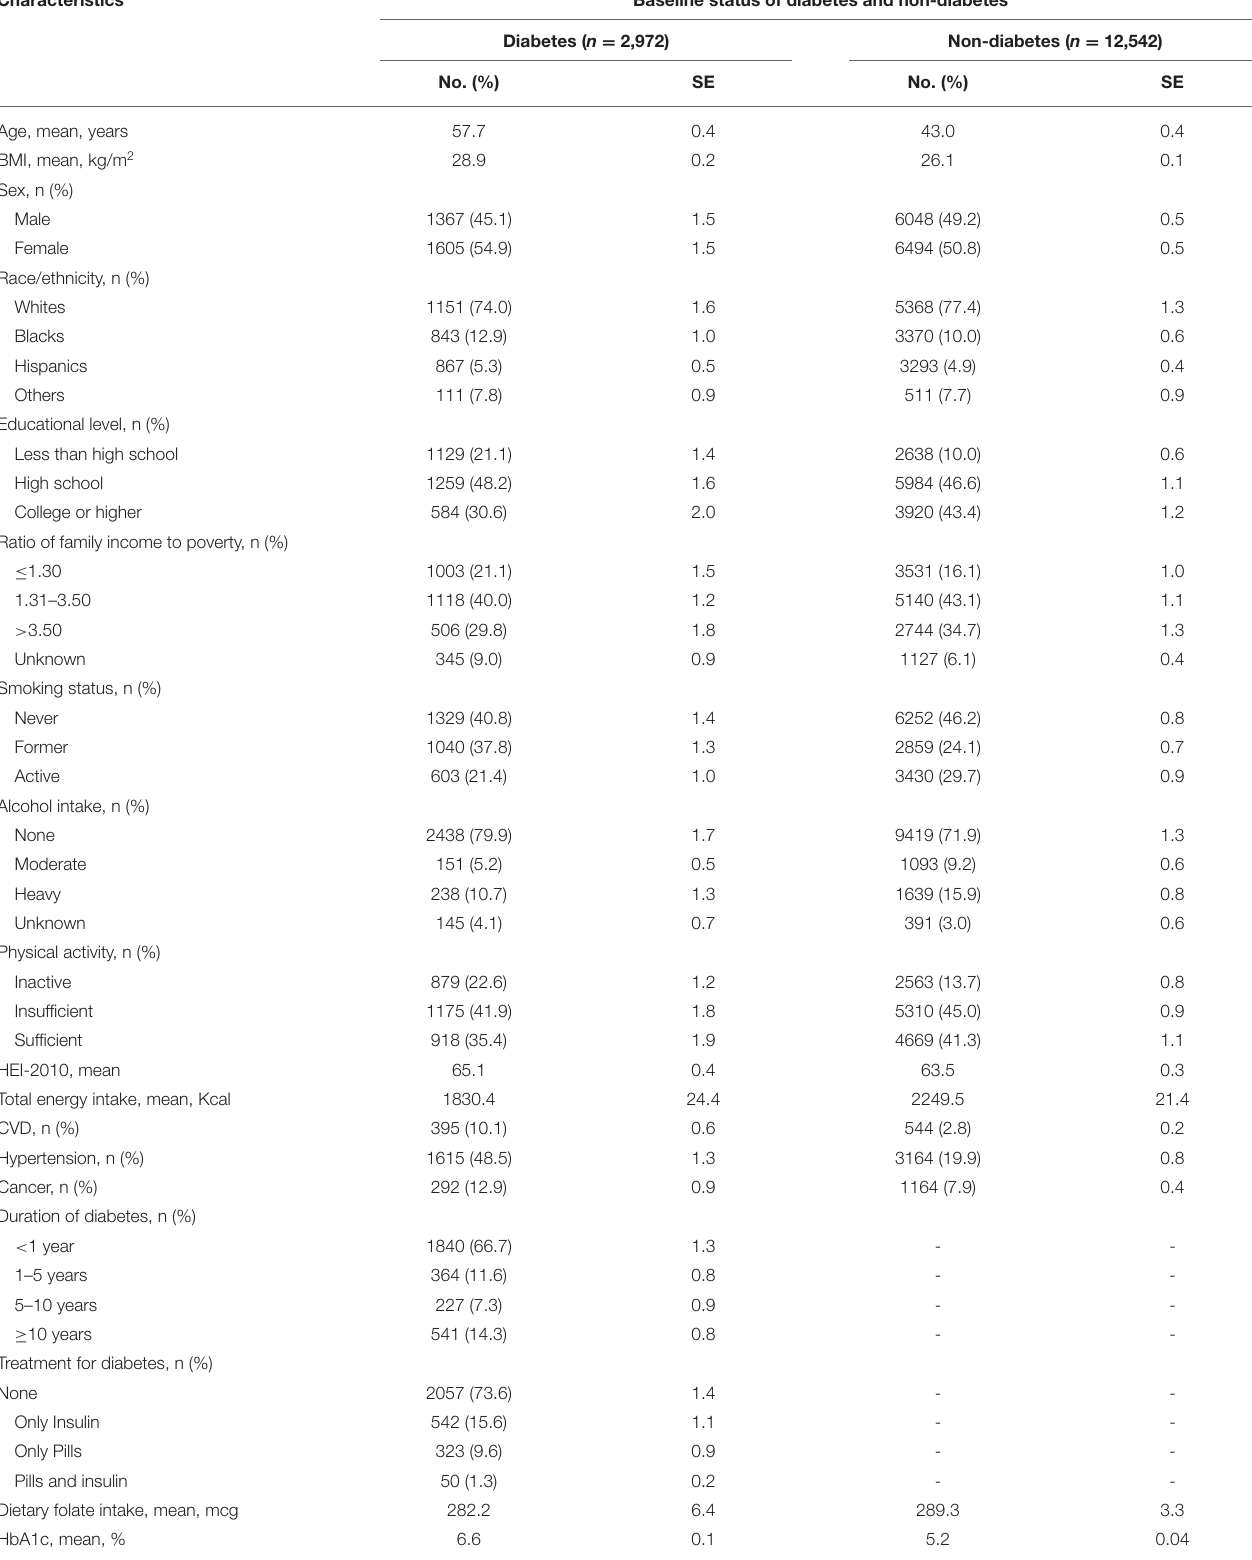
TABLE 1 | Baseline characteristics of diabetes in comparison to non-diabetes aged 20 + , NHANES III 1988–1994.